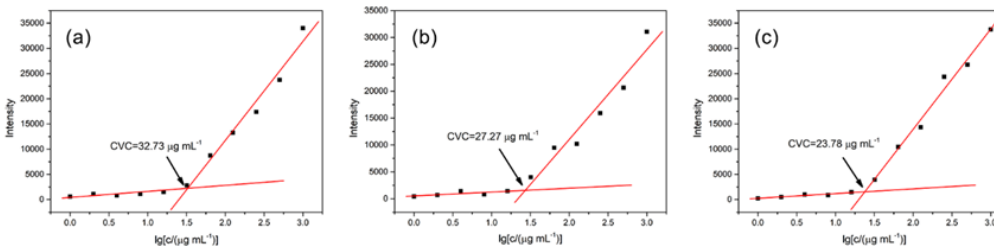
Figure 3. Determination of the Critical Vesiculation Concentration (CVC) of ( a ) PCL 16 - b -K 11 , ( b ) PCL 16 - b -K 20 , ( c ) PCL 16 - b -K 27.